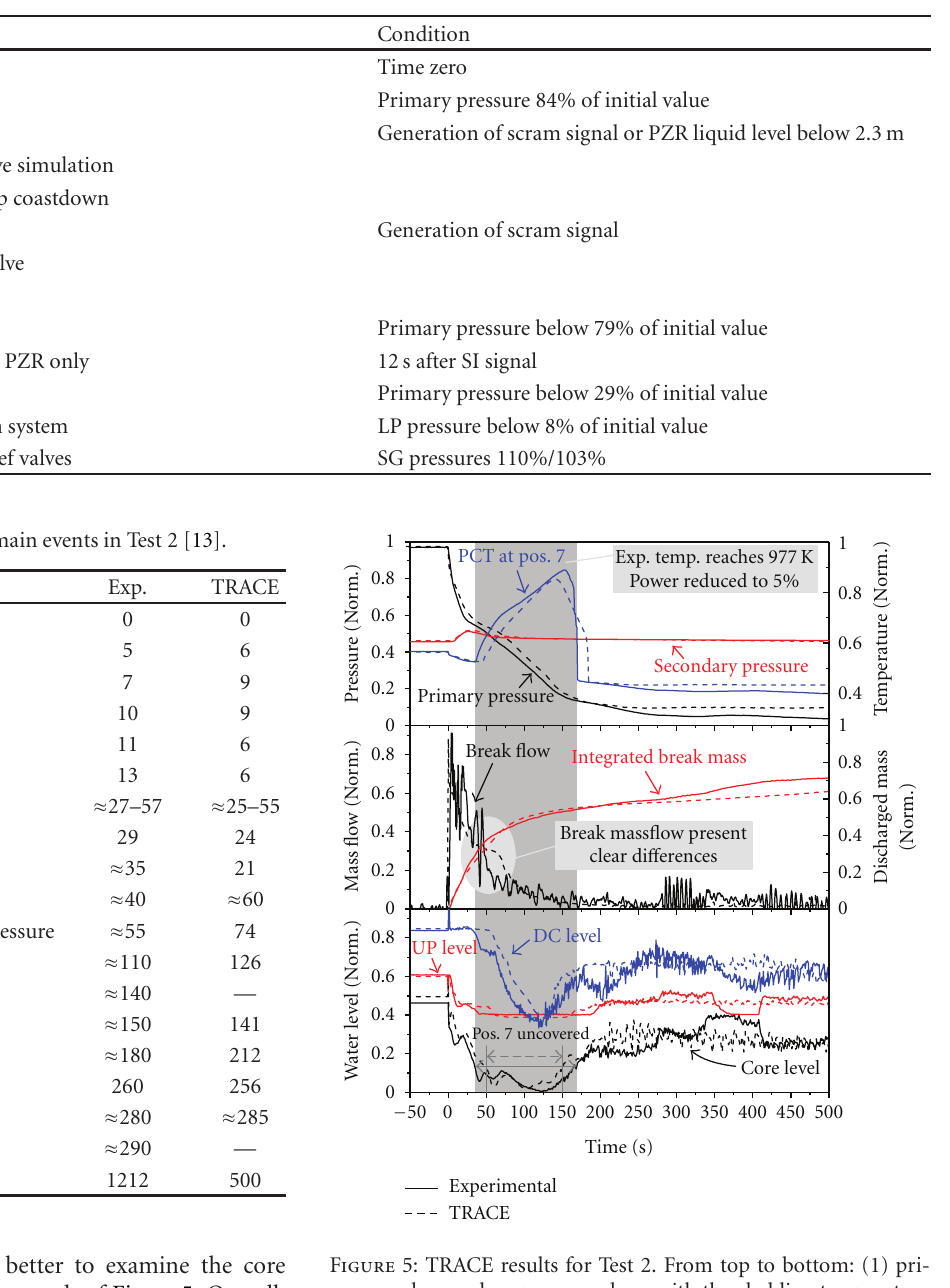
Table 8: Control logic of Test 2 [13].